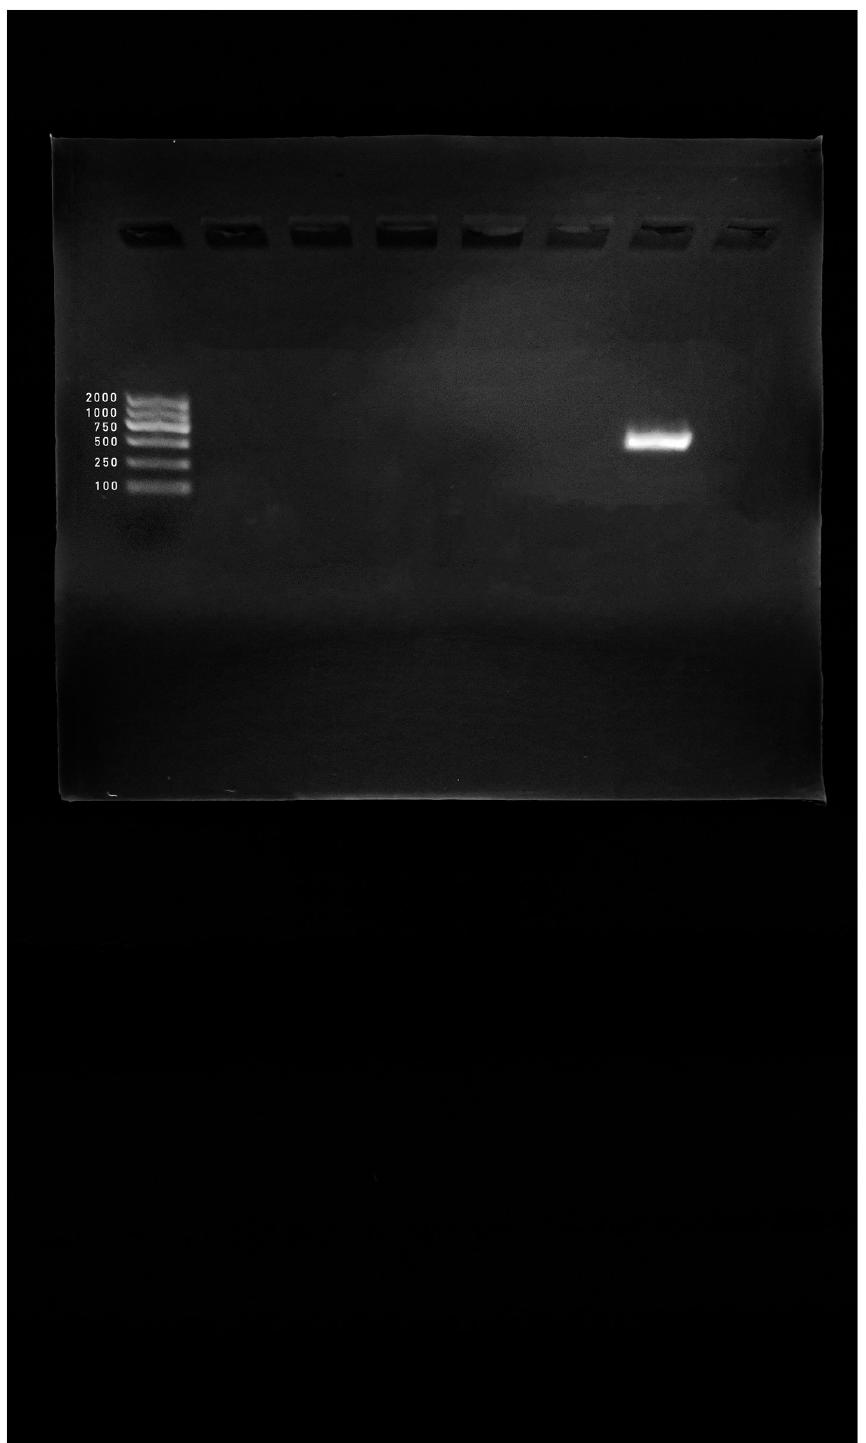
Fig 2. PCR product of raw water sample s from KSU-WWTP. Lane 1: DNA ladder, Lane 2: negative control, Lane 3–6 and 8: negative samples, Lane 7: 500 bp ( Myoviridae , CTF primer).